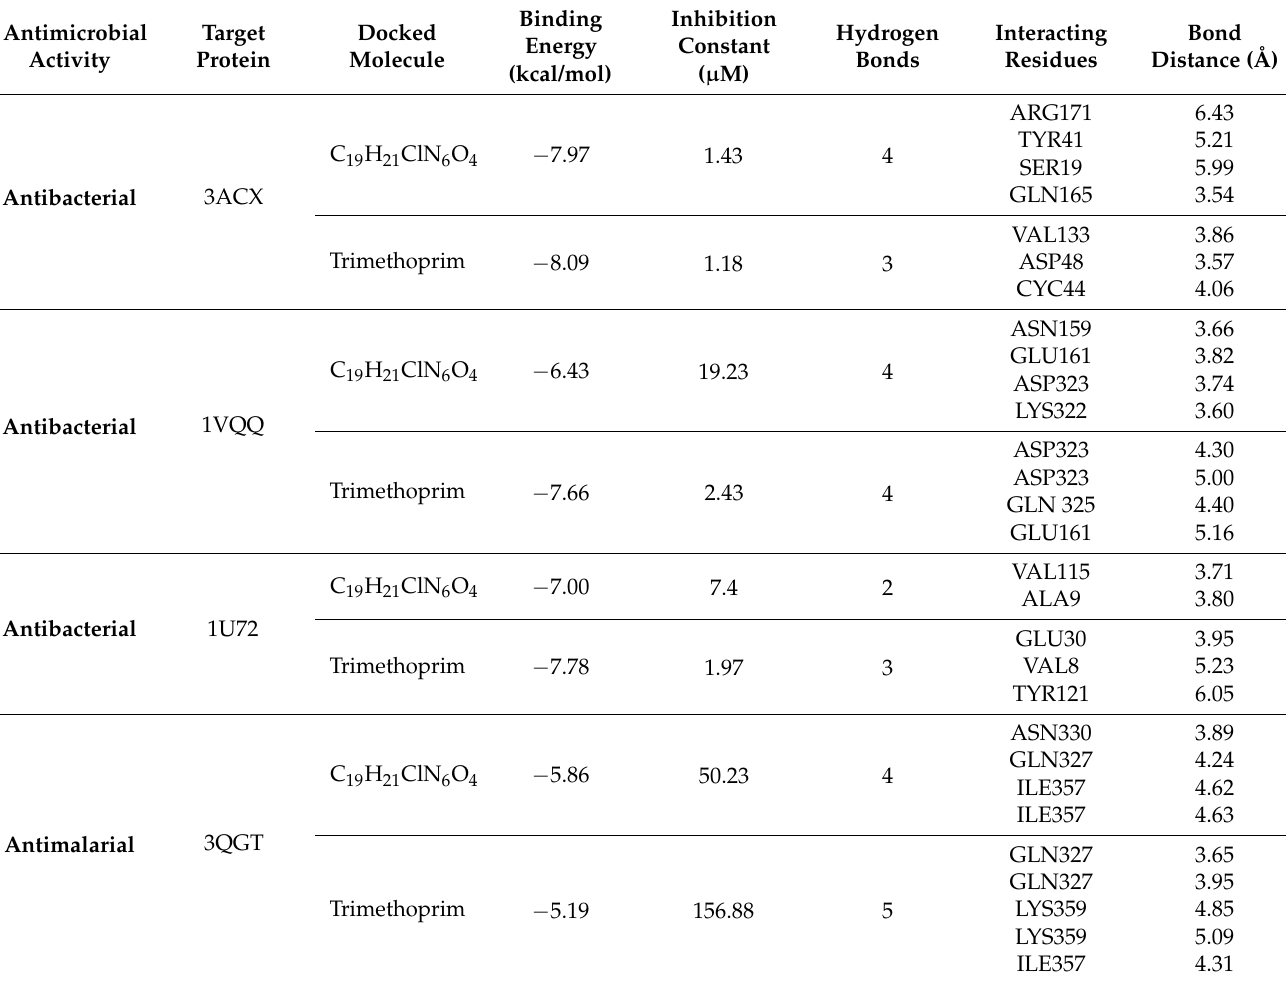
Table 5. The achieved docking results for the complexes of the studied molecule (C 19 H 21 ClN 6 O 4 ) and standard drug (Trimethoprim) with antibacterial, antimalarial target